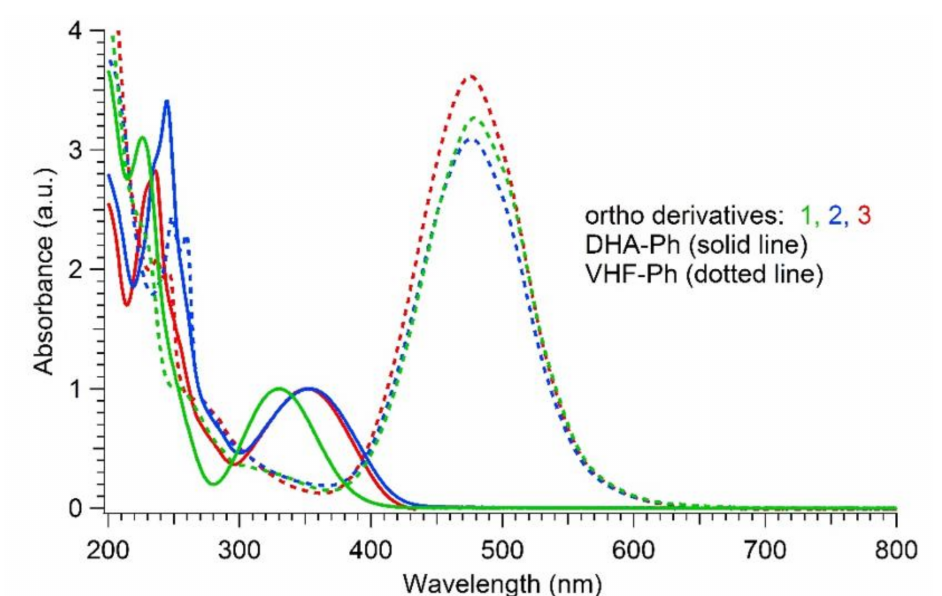
Figure 4. Normalized UV-Vis absorption spectra in MeCN of DHAs (solid line; longest-wavelength absorption maximum used for normalization) and VHFs (dotted line) for ortho compounds 1 (3.3 × 10 − 5 M, green), 2 (2.6 × 10 − 5 M, red) and 3 (1.6 × 10 − 5 M,